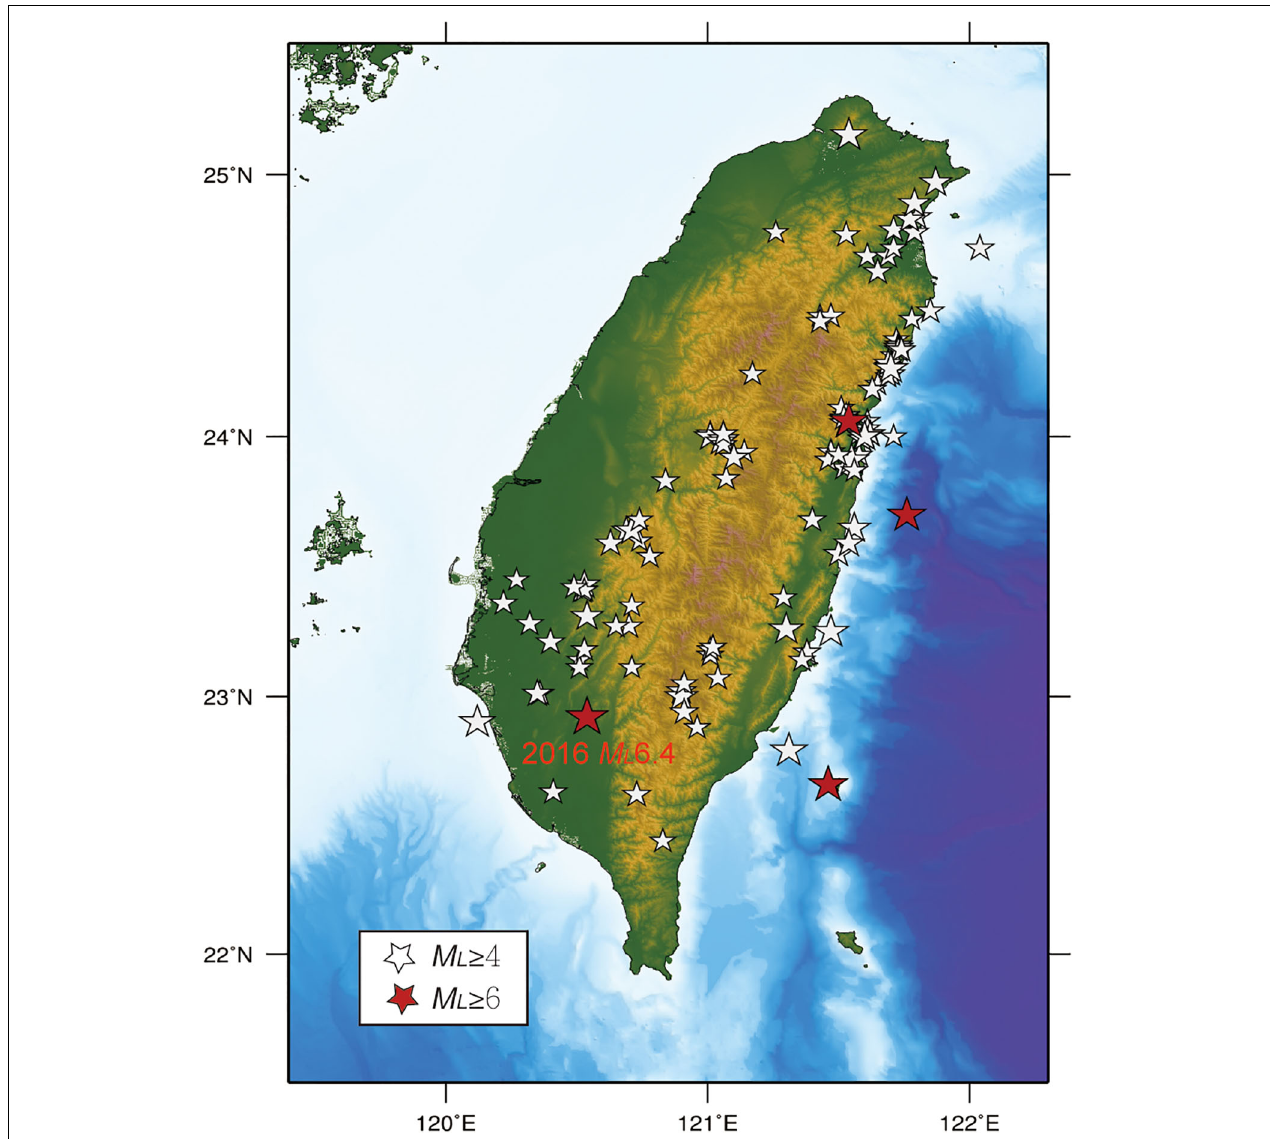
FIGURE 10 | Location of the M L > 4 inland earthquakes in the earthquake game competition (the same events listed in Figure 9 ). White stars indicate events with magnitude greater than 4 but smaller than 6. Red stars indicate events with magnitude greater than